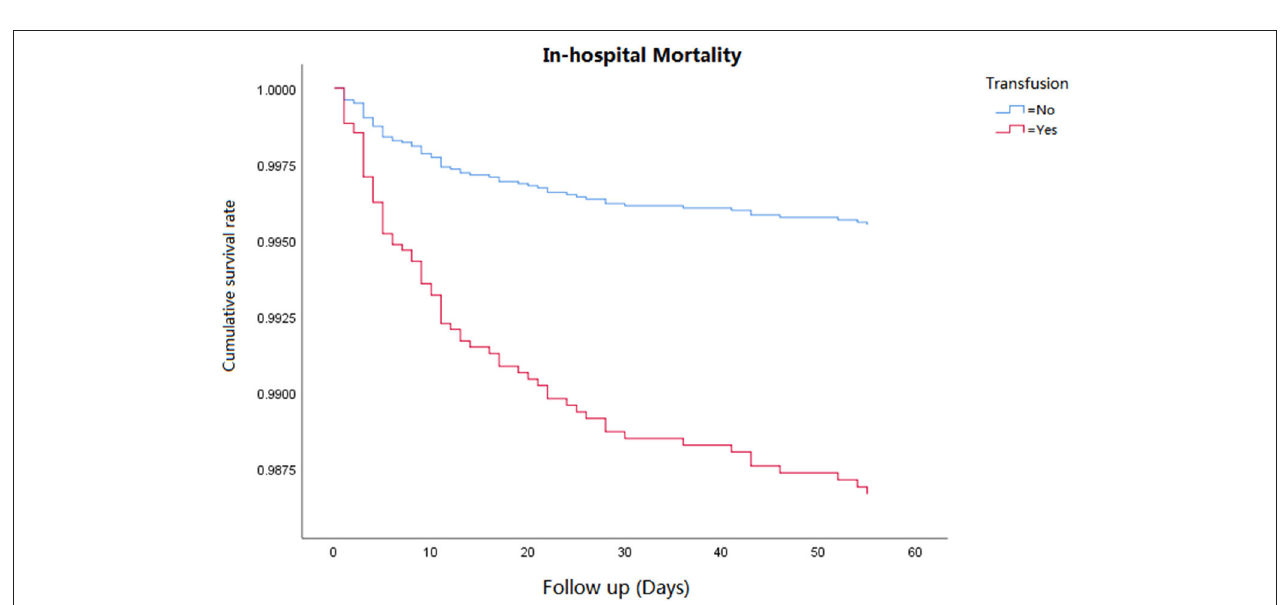
FIGURE 2 | Correlation between perioperative red blood cell transfusion and inhospital mortality.